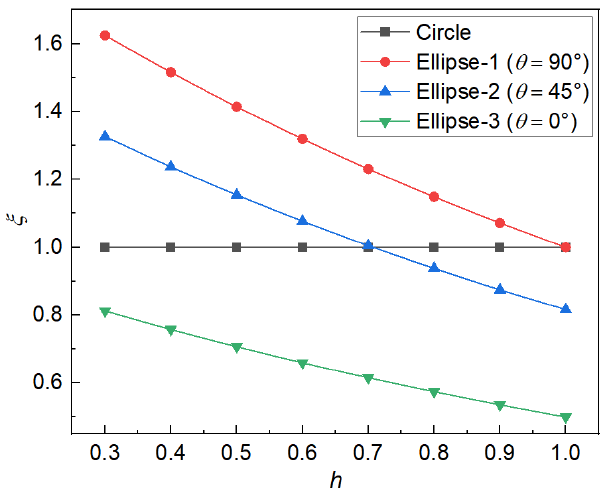
Figure 9. The variations of shape indicator ξ with h under different inclusion shapes.